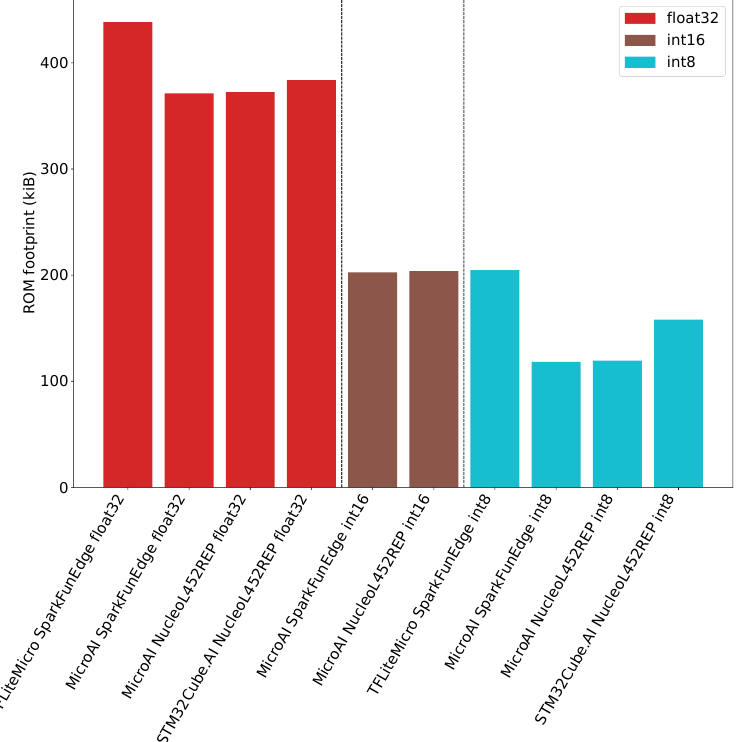
Figure 11. ROM footprint for TFLite Micro, STM32Cube.AI and MicroAI with 80 filters per convolution.